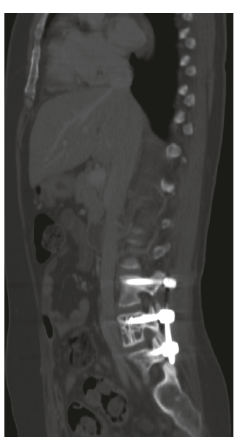
Figure 5: CT. Sagittal view. Pedicle screw fixation of L3-L5 after subtotal